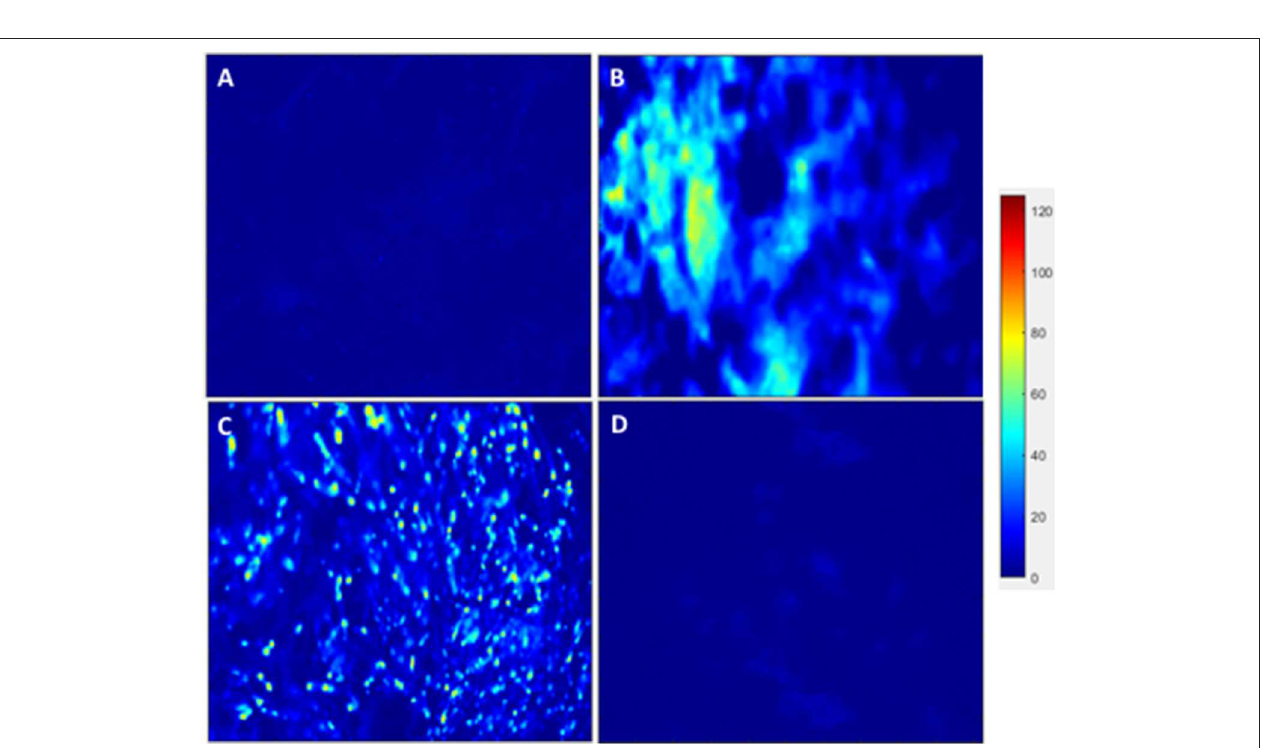
FIGURE 12 | hBM-MSCs differentiation toward α -SMA heat map. PGA-PLLA scaffolds seeded with hBM-MSCs from previous experiments (5) compared to our experiments demonstrating heat maps of α -SMA in averaged (A) static, (B) PHV, (C) flex-flow, and (D) oscillatory flow groups. Resolution of 1,024 × 690 pixels.